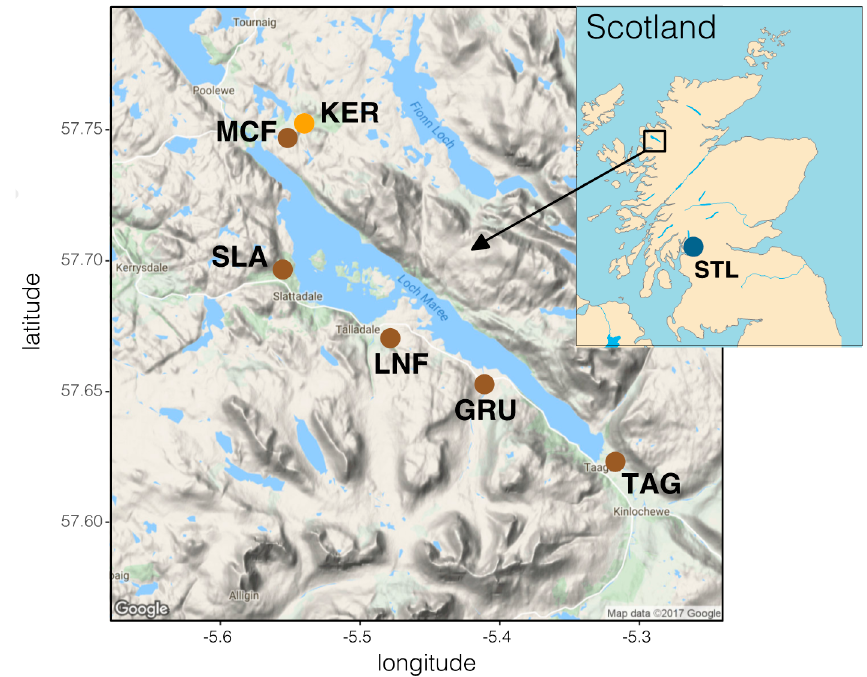
Figure 1. Map of sampling sites in Scotland and the Maree catchment. Benthivorous brown trout (brown dots) were sampled from Taggan (TAG), River Grudie (GRU), Loch na Fideil (LNF), River Slattadale (SLA) and the MacFarlane burn (named for this study, MCF). Ferox trout from the Maree catchment (orange dot) were sampled from the Kernsary river (KER). Sampling sites of sea trout from Loch Lomond (STL) are marked with a blue dot. An overview of sample numbers is given in Table 1.